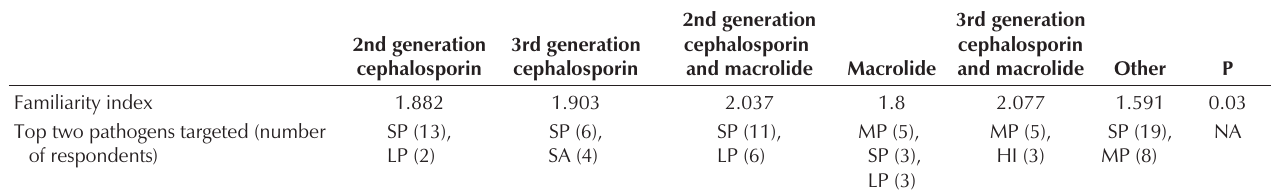
Factors found to be significant correlates of respondent choice of antibiotic for case 3 – A 45-year-old woman with no comorbidity and severe clinical presentation